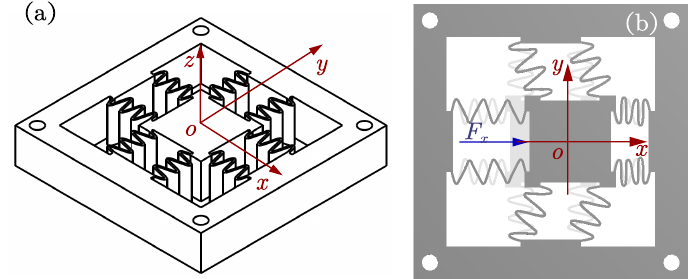
Figure 4. Structure of the sinusoidal corrugated dual-axial mechanism: ( a ) 3-D structure and ( b ) de- formation